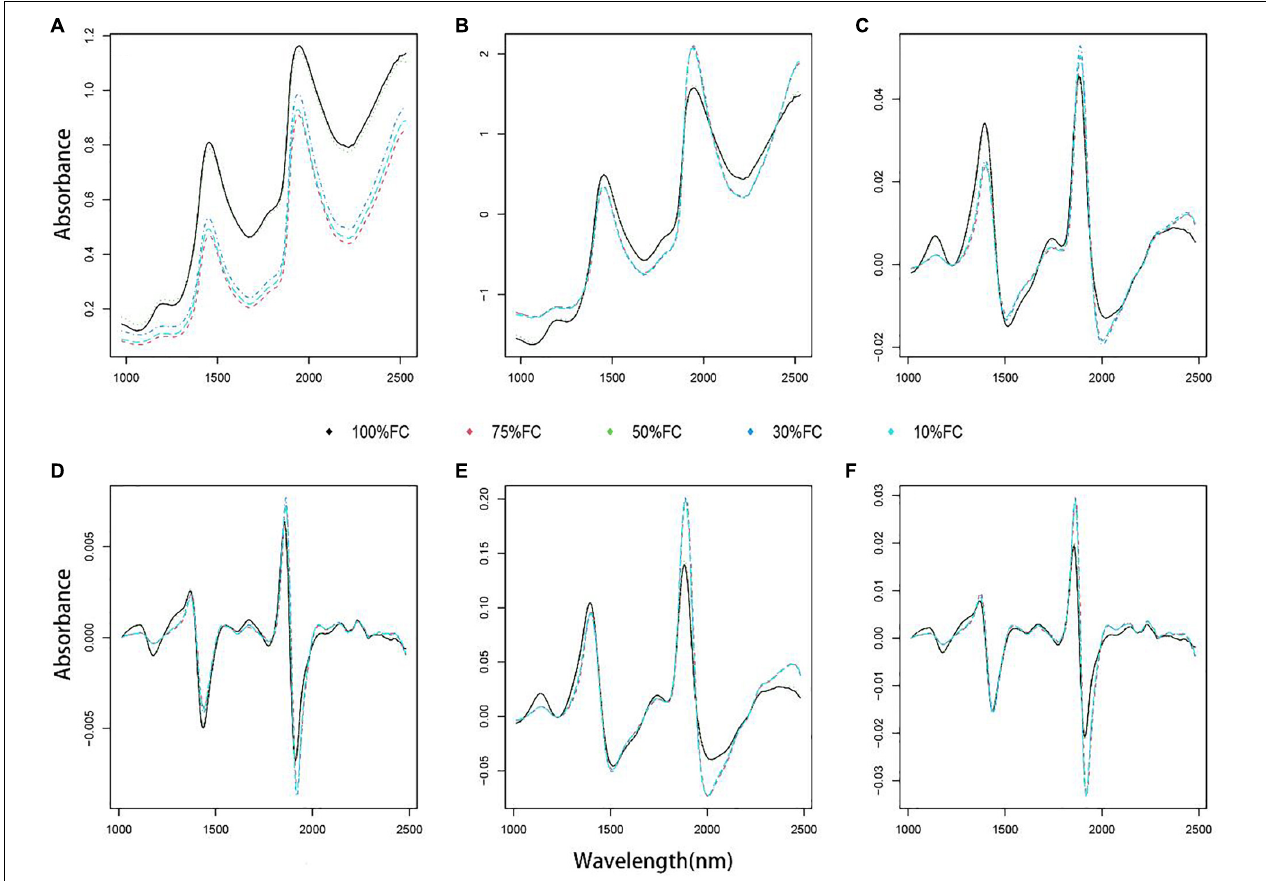
FIGURE 1 | Original and various pretreatment spectra of T. sinensis seedling leaves collected under distinct water gradients. (A) Original spectra, (B) SNV: SNV spectra, (C) FSG: the first derivative combined with S-G smoothing spectra, (D) SSG: the second derivative combined with S-G smoothing spectra, (E) SNV_FSG: SNV combined with the first derivative and S-G smoothing spectra, (F) SNV_SSG: SNV combined with the second derivative and S-G smoothing spectra.